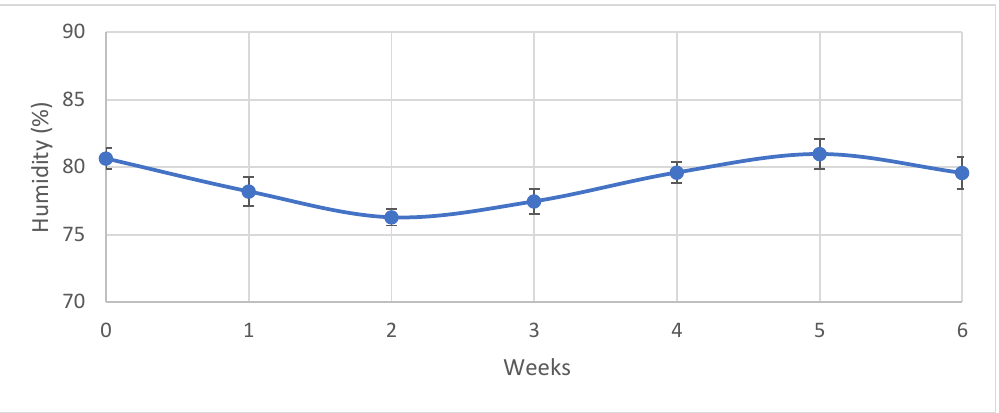
Figure 3. Corn cob waste humidity behavior in pre-composting.